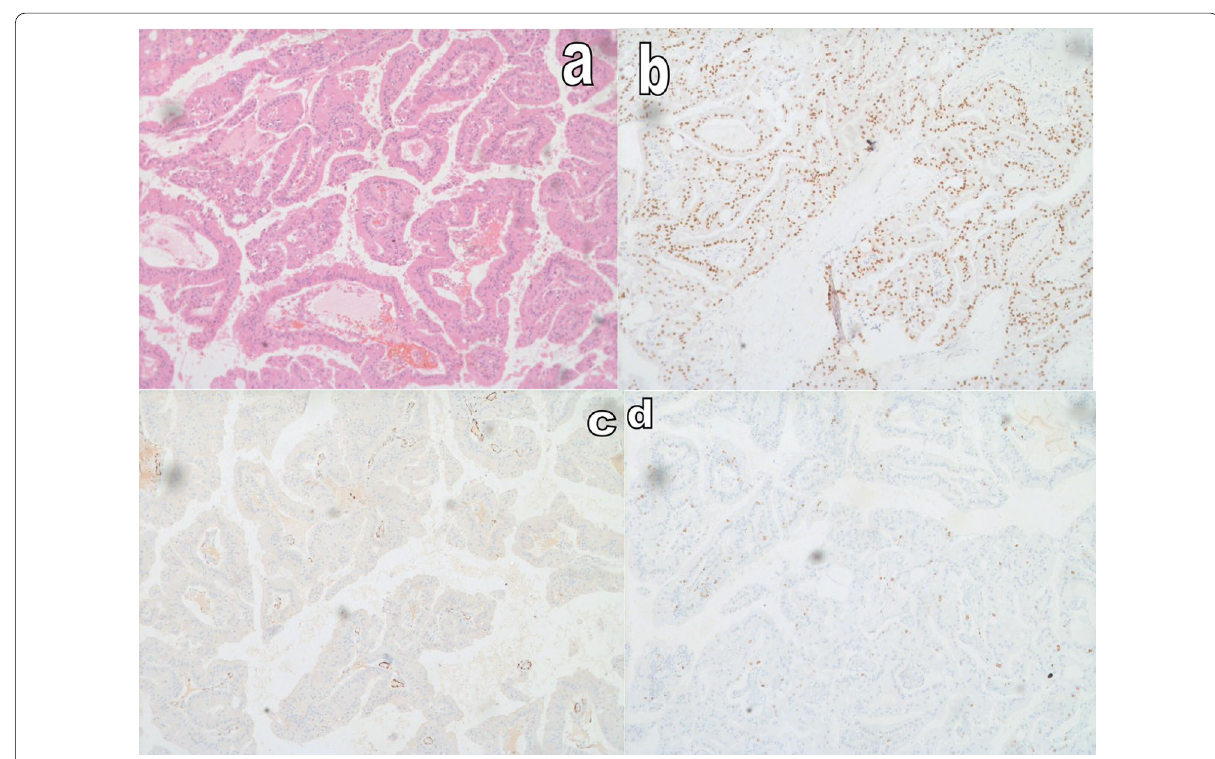
Fig. 6 Ectatic duct showing intra ductal tumor arranged in tubulo-papillary pattern on histopathology ( a ), AR positive in epithelial cells ( b ). Myoepithelial cell express calponin ( c ), KI-67 index of 15% ( d